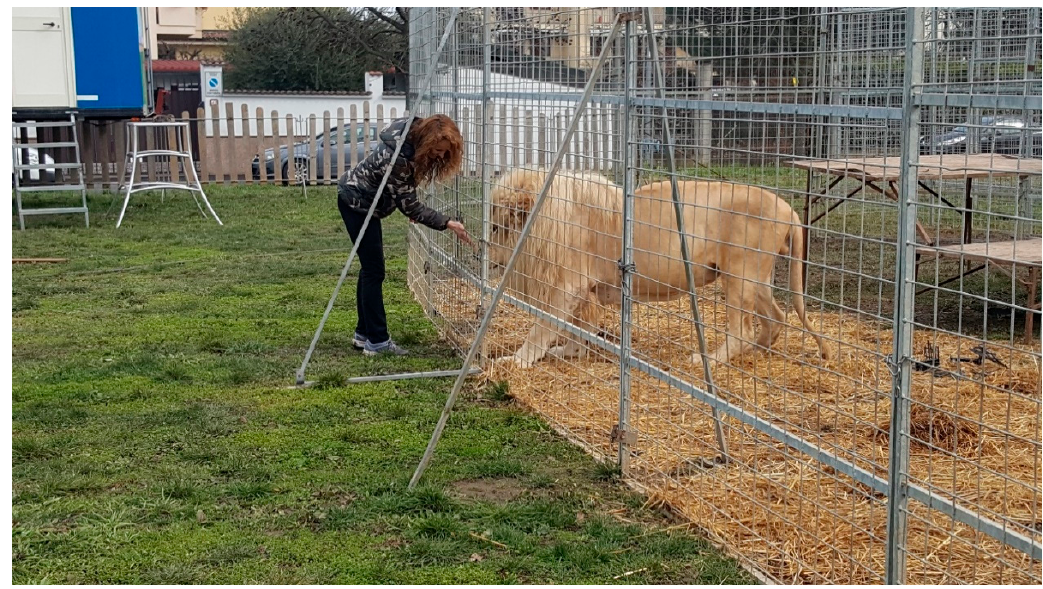
Figure 3. Feeding a body temperature logger to Zeus, the adult male.